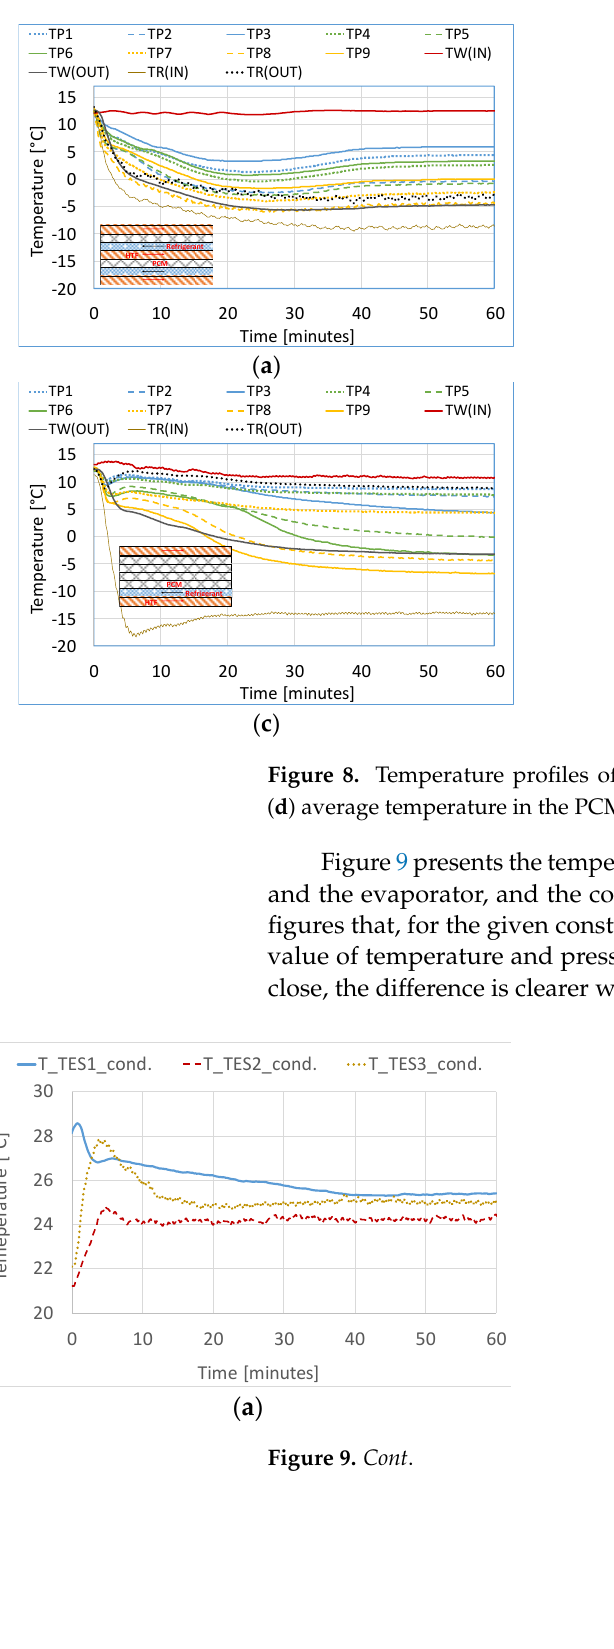
( b ) Figure 7. Energy and power during the discharging process: ( a ) energy discharged against average temperature and ( b ) energy discharged and average discharging power during the whole process. 3.6. Temperature Evolution in Three-Fluids HEX Operating Mode Figure 8 shows the temperature profiles in the three-fluids HEX operating mode. The cold energy from the refrigerant was delivered to both the HTF and the PCM, resulting in